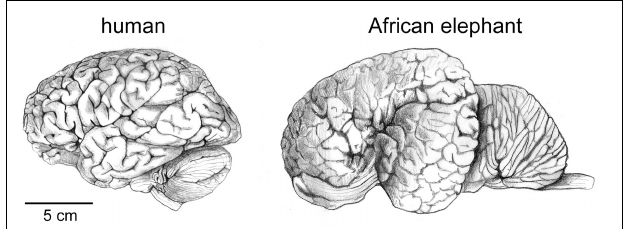
FIGURE 1 | The human brain is not the largest. Brains of a human and of an African elephant are depicted here at the same scale. Drawings by Lorena Kaz based on images freely available from the University of Wisconsin and Michigan State Comparative Mammalian Brain Collections